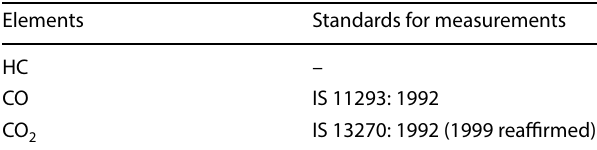
Table 7 The summary of Indian National standards used for the analysis of emission Elements Standards for